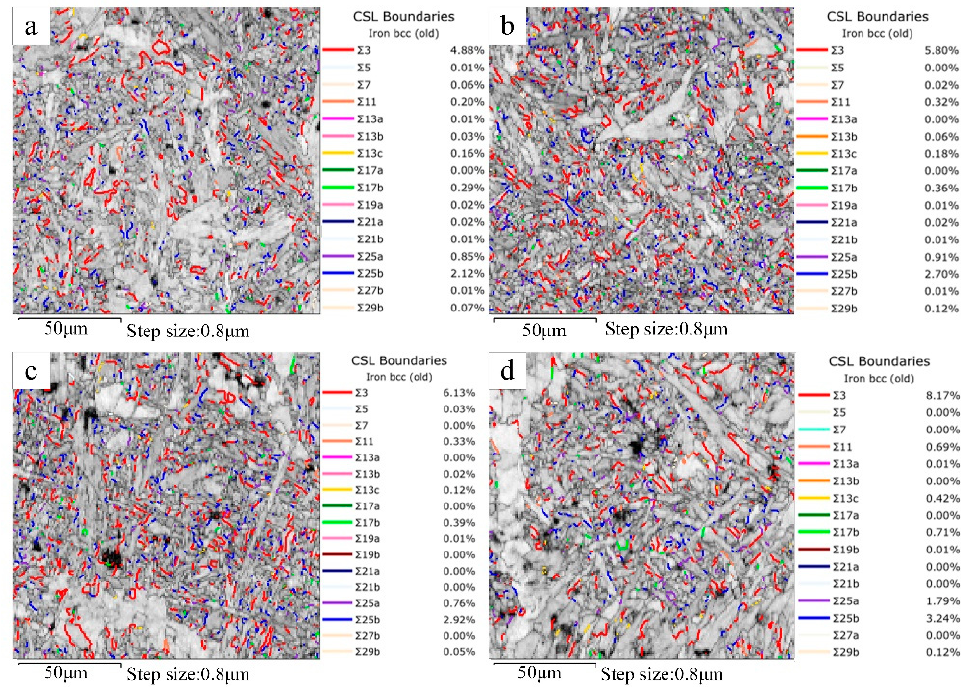
Figure 13. The detailed CSL boundaries distributions of welded joints. ( a ) In air and ∆ K , is 45 MPa·m 1/2 ; ( b ) in air and ∆ K , is 60 MPa·m 1/2 ; ( c ) in water and ∆ K , is 45 MPa·m 1/2 ; ( d ) in water and ∆ K , is 60 MPa·m 1/2 .